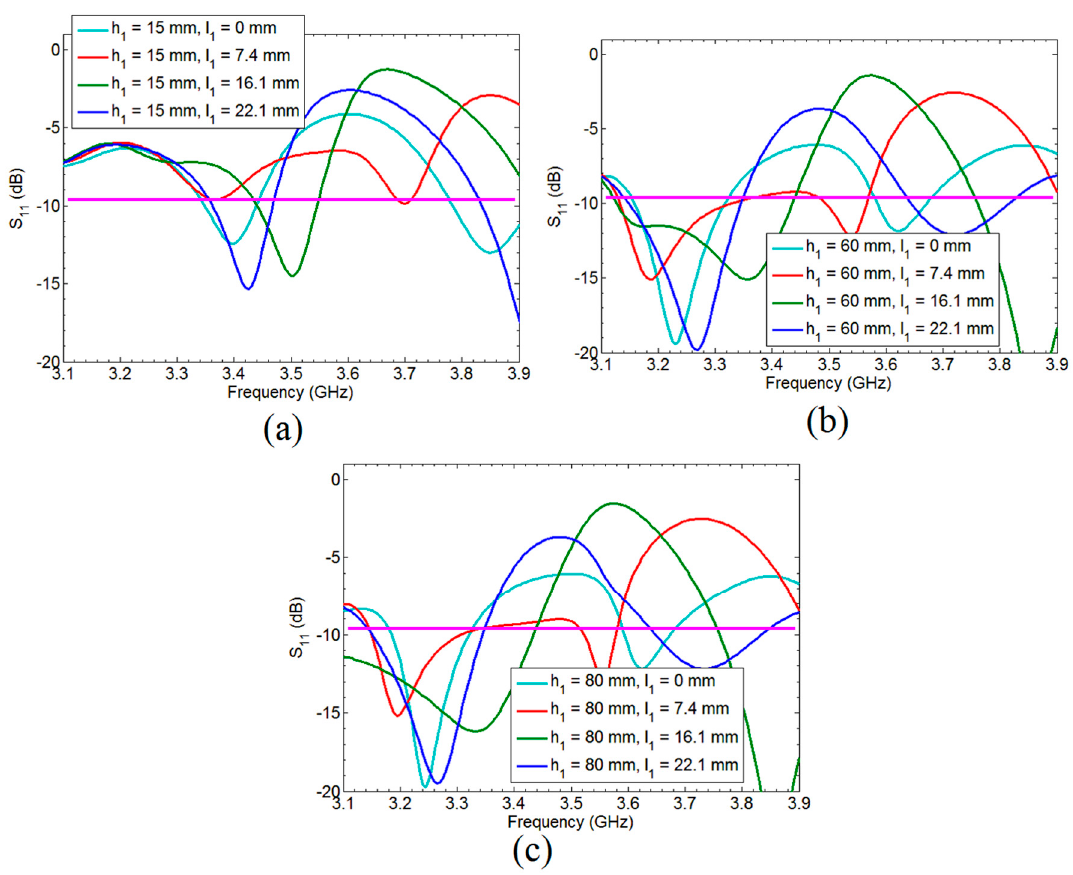
Figure 9. Parametric analysis of the Critical parameters of the fan beam array antenna; ( a ) Different l 1 values having h 1 = 15 mm; ( b ) Different l 1 values having h 1 = 60 mm; ( c ) Different l 1 values having h 1 = 80 mm.